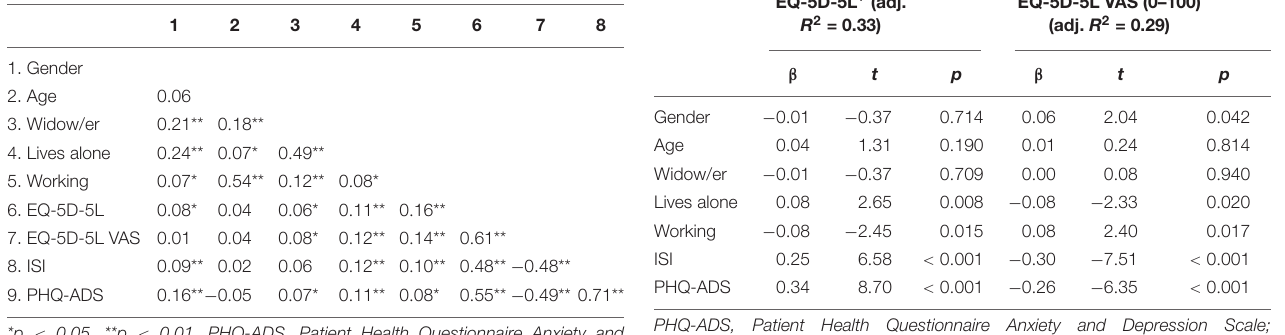
TABLE 5 | Correlations between demographic variables, symptoms measures, and quality of life.